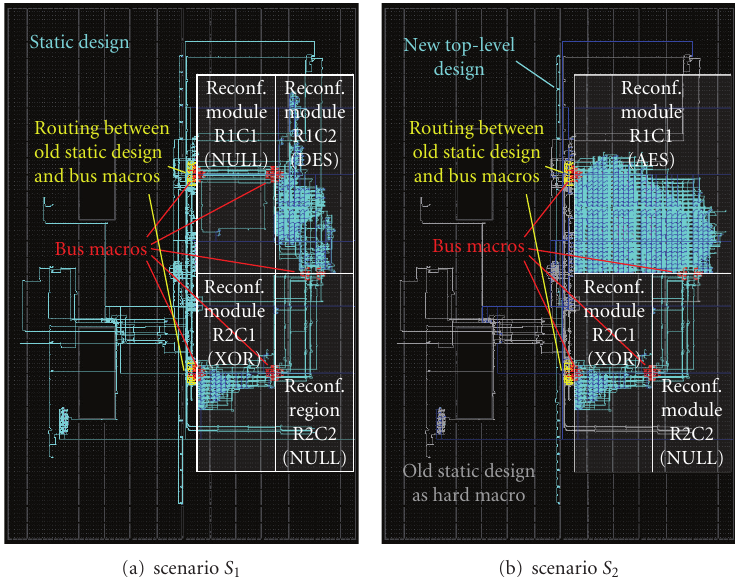
Figure 8: Complete designs (PR modules merged in static design).